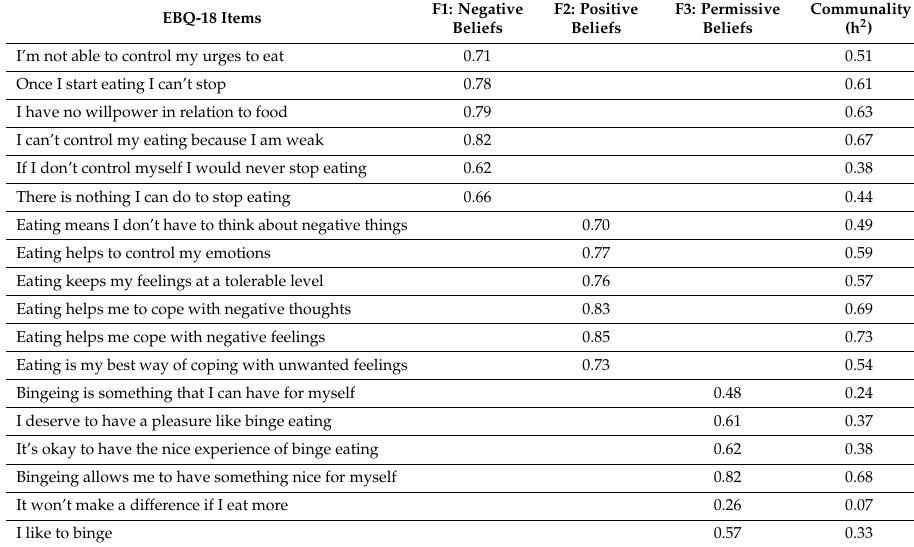
Table 2. Results of a Confirmatory Factor Analysis of the Eating Beliefs Questionnaire (EBQ-18) with the binge eating sample ( n = 190) Standardised Regression Weights &